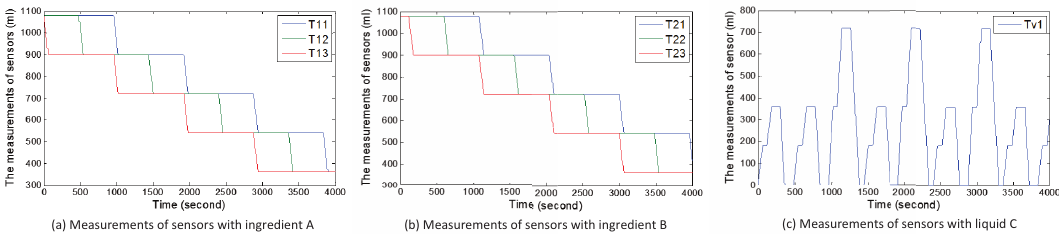
Figure 10. Measurements from sensors under the normal situation of scenario 1.